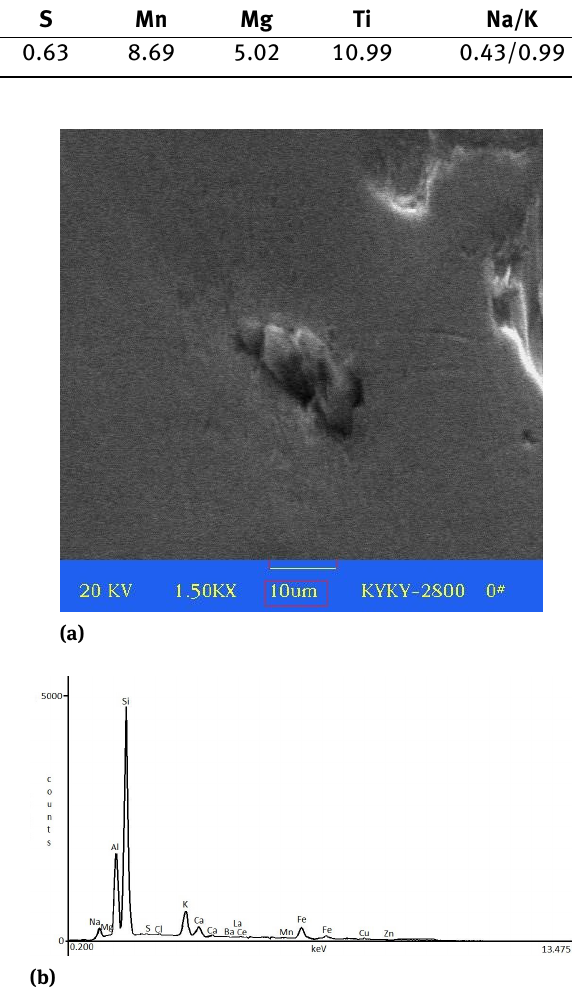
Figure 3: ( a ) Stereoscan photograph and ( b ) energy spectrum analy- sis of silicon–alumina duplex impurity.